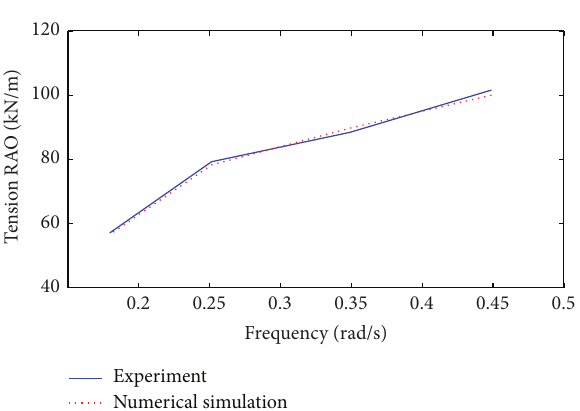
Tension sensors are connected at the top between the lines and floater to measure the tensions acting on the mooring lines. The customized FQ-1 type tension sensors, each of 2.0 kg capacity with a comprehensive accuracy of 0.03% FS, are equipped with a digital signal recorder box for data acquisition. Three degrees of freedom motions (surge, heave, and pitch) of the floater are measured by a CCD camera system that uses a high-speed camera sensing two LED signals (Figure 2) attached on the model.